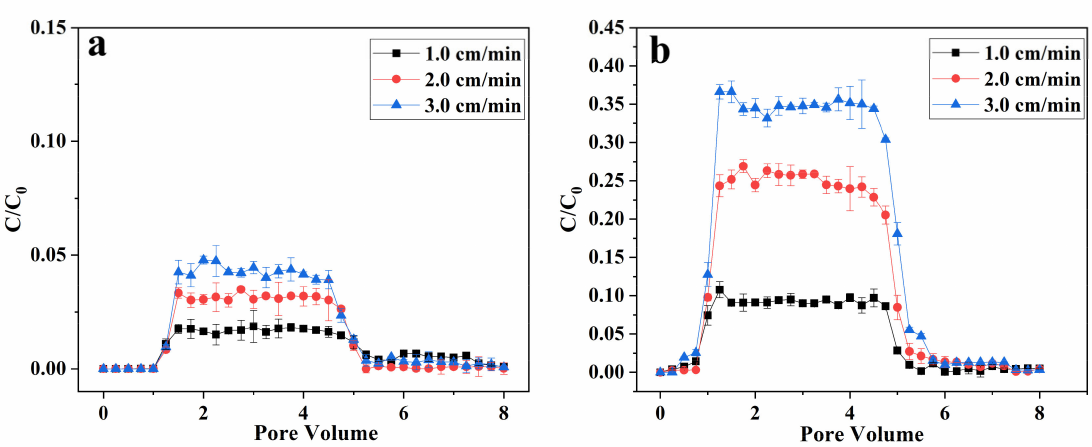
Figure 4. Breakthrough curves of nZVI ( a ) and B-nZVI ( b ) at different pore velocities through quartz sand columns. Error bars represent standard deviations of triplicate